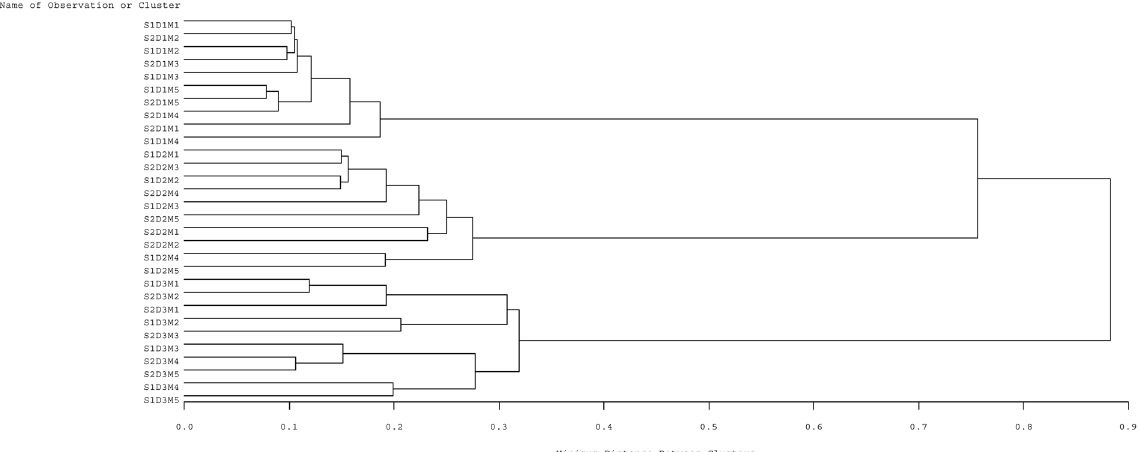
Figure 4. Hierarchical cluster analysis of exogenous melatonin in two Salvia species under reduced irrigation regimes, based on enzymatic and non-enzymatic antioxidant properties and essential oil yield. S1: Salvia nemorosa L., and S2: Salvia reuterana Boiss. D 1 : irrigation at 80% Fc, D 2 : irrigation at 60% FC, D 3 : irrigation at 40% Fc,